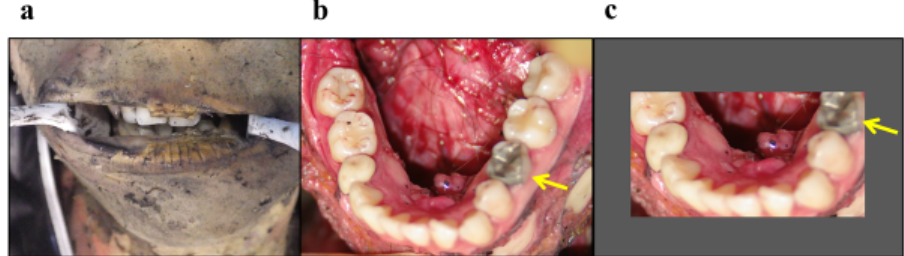
Figure 4. Misidentification of the primary molar as molar teeth because of the narrow opening of the mouth. ( a ) The frontal view before autopsy. Opening of mouth and removal of lips was attempted in vain before imaging. ( b ) The mandibular occlusal surface view after autopsy. Late residual mandibular left second primary molar led us to determine a missing premolar. The arrow indicates the tooth mistaken for the mandibular left first molar with previous insufficient mouth opening. ( c ) The photographic image of the mandibular occlusal surface view when the mouth is less open.